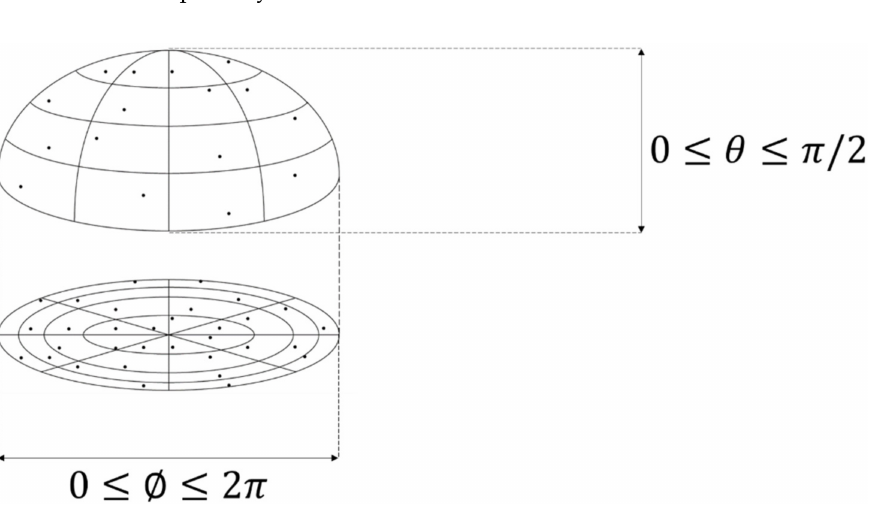
Figure 4. An illustration of the original sampling pattern employed in RADIANCE. The dots represent individual samples over the projected hemisphere